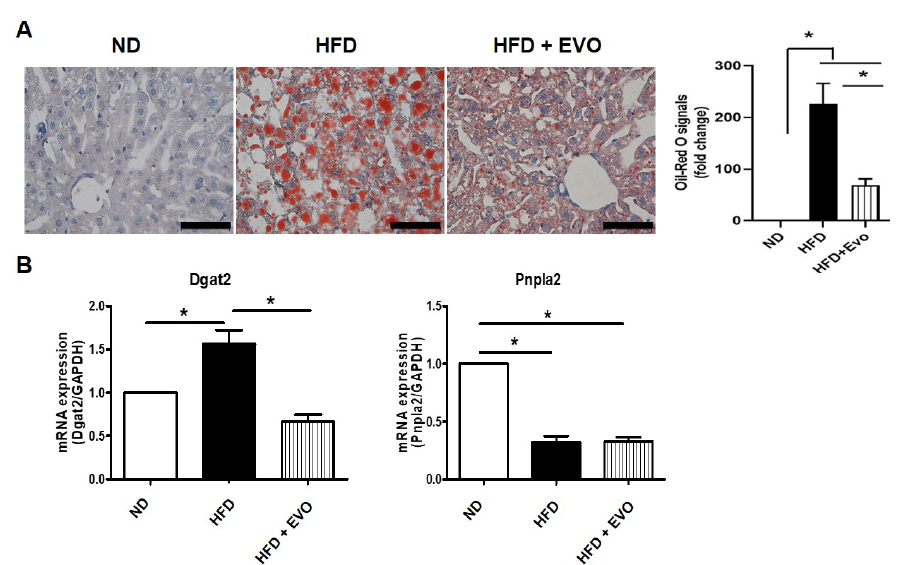
Figure 2. Evogliptin decreased hepatic lipid accumulation: ( A ) liver sections stained with Oil Red O. Scale bar, 50 μm. ( B ) mRNA levels of lipid metabolism-related genes as determined by qPCR: GAPDH was used as an internal control. Values are mean ± SEM. * p < 0.05, HFD: high-fat diet; ND: normal diet.